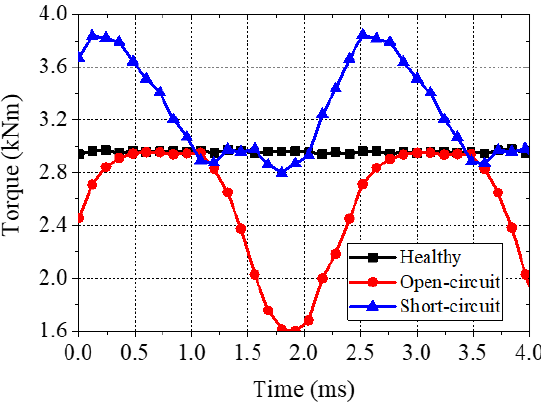
Figure 19. Torque performance of the proposed machine under healthy, 1-phase open-circuit, and 1-phase short-circuit.